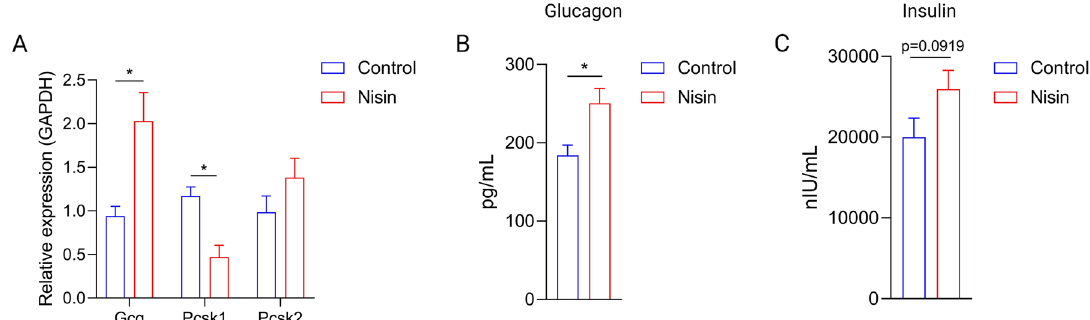
Fig. 7 Nisin induced GLP-1 related glucoregulatory hormones secretion alteration. A RNA expression of Gcg, Pcsk1 and Pcsk2 ( n = 6). B Glucagon level in the serum ( n = 8). C Insulin level in the serum ( n = 8). Signi fi cance was determined using two-tailed unpaired t -tests. The values are expressed as the means ± S.E.M. * P <